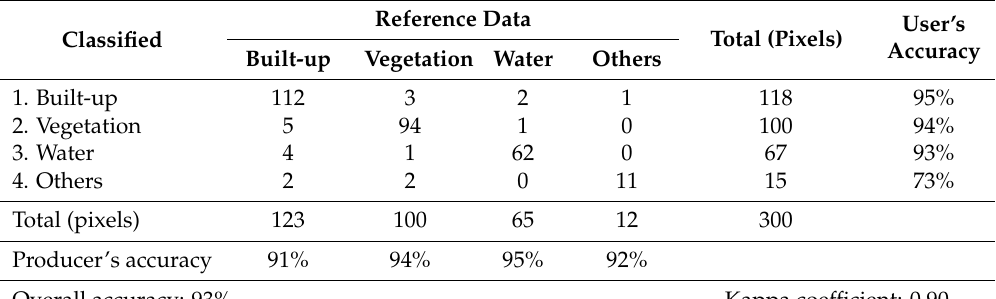
Table 4. Confusion matrix of land-use map classified from the Landsat 8 image in 2017.